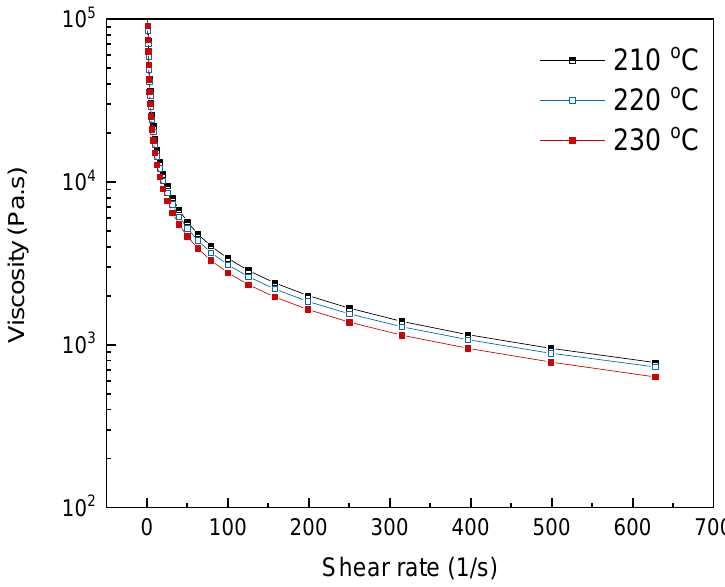
Figure 1. Viscosity curves of the composite material at 210, 220 and 230 °C.